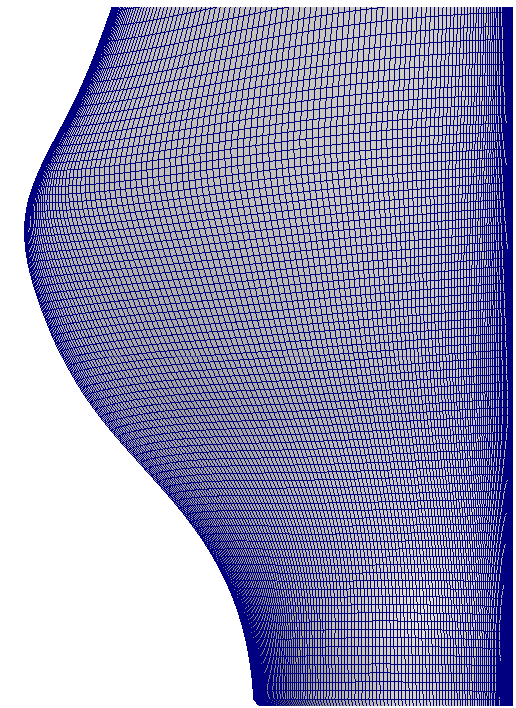
Figure 4. Detail of the surface mesh in the blade root region.